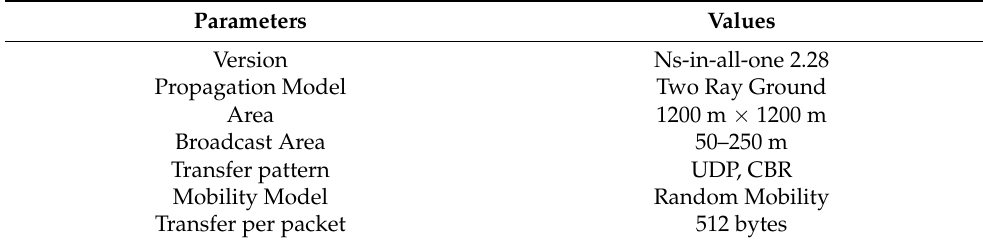
Table 3. Simulation